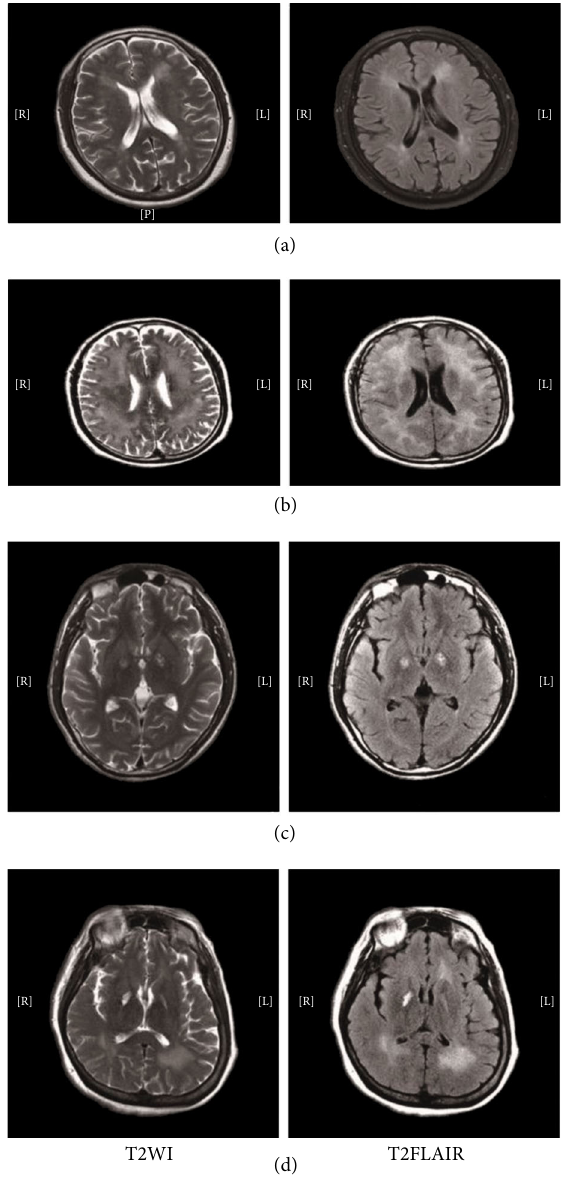
Figure 1: Magnetic resonance imaging (MRI) scan showed high signal intensity in the bilateral cerebral white matter (a, b) and the globus pallidus(c,